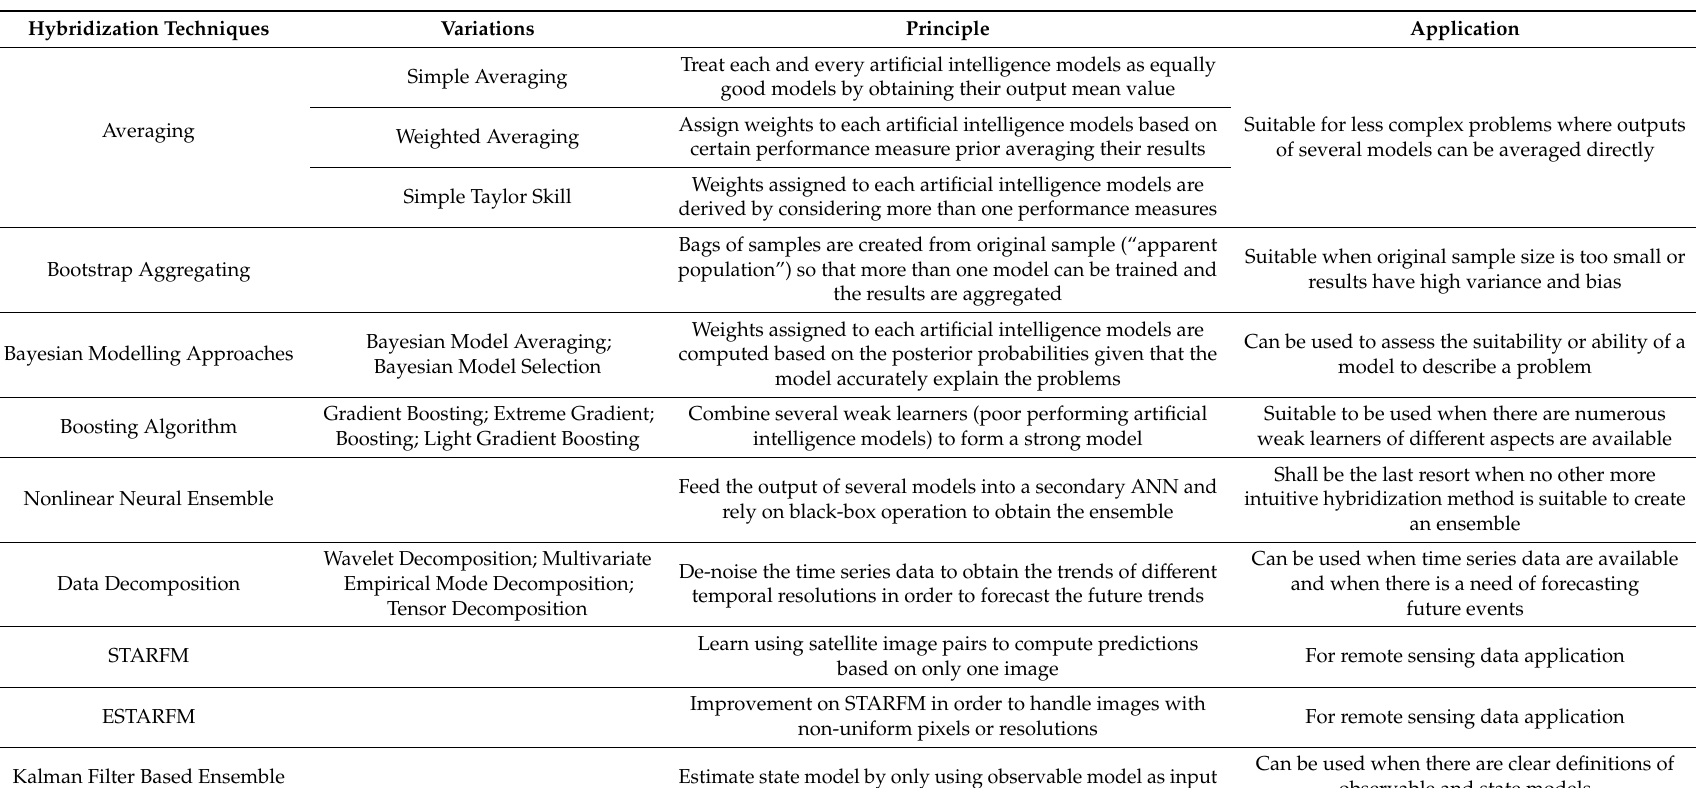
Table 4. Overview of di ff erent hybridization